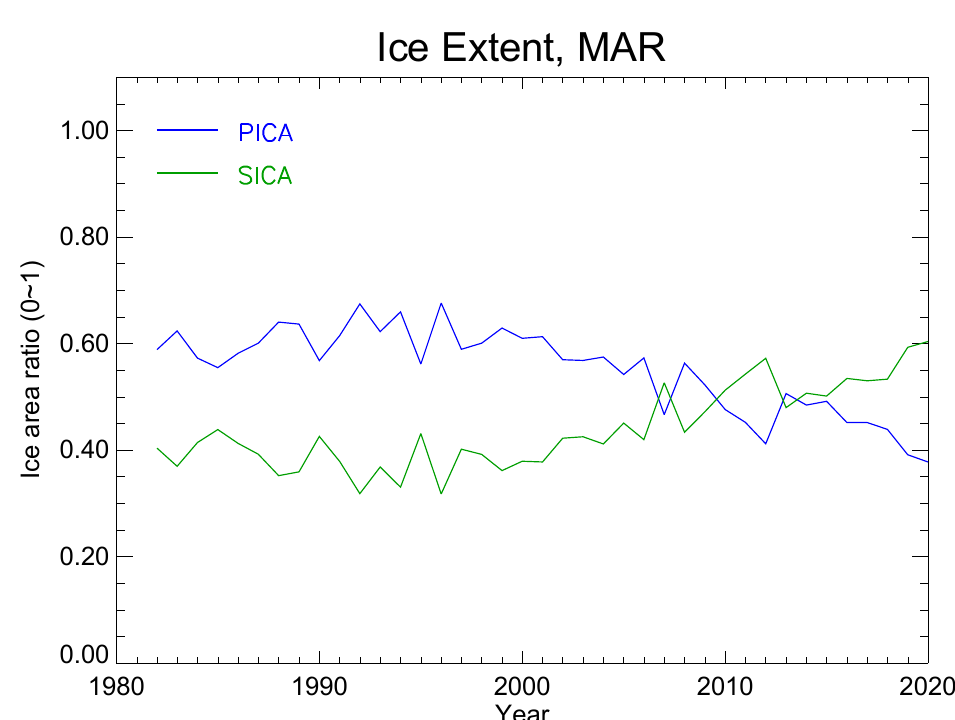
Figure 4. Ratios of PICA SIE and SICA SIE to AICA SIE in March over 1982–2020 for the Arctic area north of 60°N.